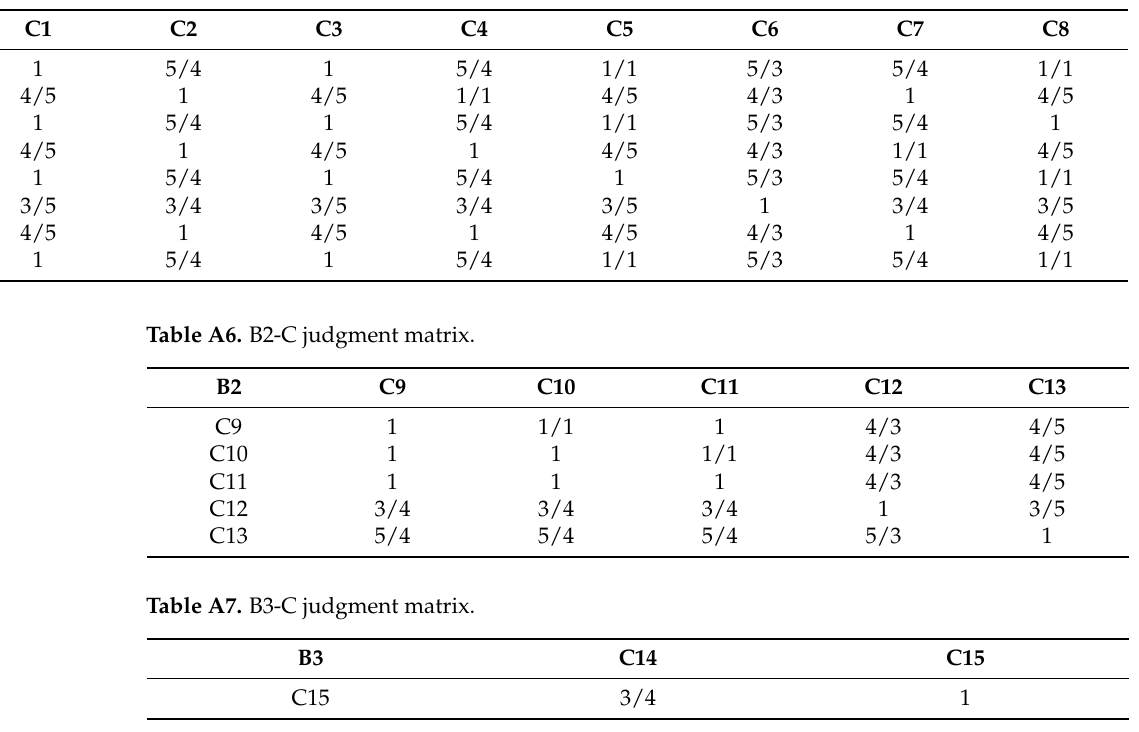
Table A5. B1-C judgment matrix.